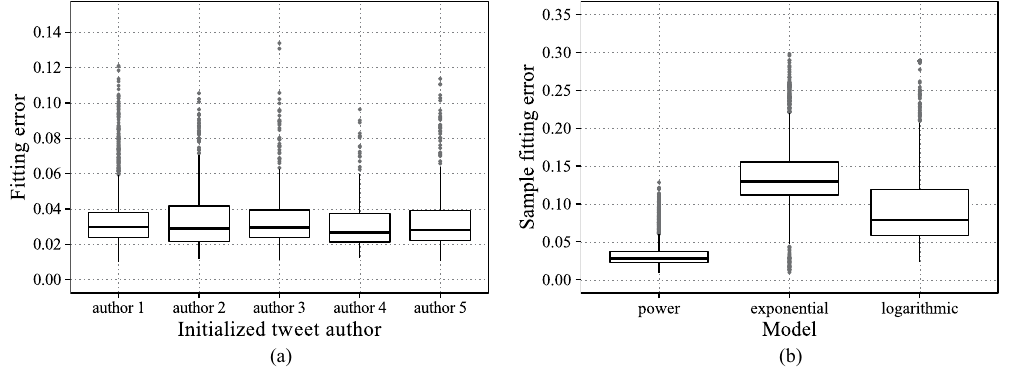
Figure 6. Model Fitting Results. ( a ) Distribution of fitting errors for the top 5 most active authors. ( b ) Comparison of fitting error distributions using different models.